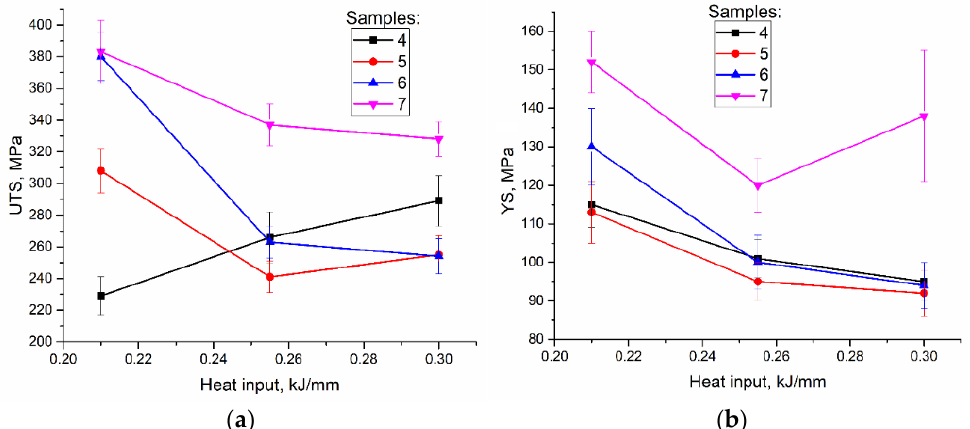
Figure 13. UTS ( a ) and YS ( b ) vs. heat input dependencies. Strain-to-fracture dependencies of samples 5, 6, and 7 on the heat input show a ten- dency for improving plasticity of all samples at heat input 0.255 kJ/mm as compared to that of at 0.21 kJ/mm and then reducing it at 0.3 kJ/mm (Figure 14). The highest plasticity was achieved at 0.255 kJ/mm on sample 5 (cut off the top part of the wall). Figure 14. Strain-to-fracture vs. heat input dependencies. Fracture surface of a sample grown at 0.21 kJ/mm can be classified as a surface ob- tained as a result of mixed viscous/brittle fracture mechanism. Quasi-brittle fracture mi- crogrooves can be observed in Figure 15b along with microcells (Figure 15a), usually in- herent with the viscous fracture. Fracture surfaces of samples printed at 0.255 kJ/mm (Fig- ure 15c) and 0.3 kJ/mm (Figure 15d) demonstrate the presence of only viscous fracture microcells and ridges.